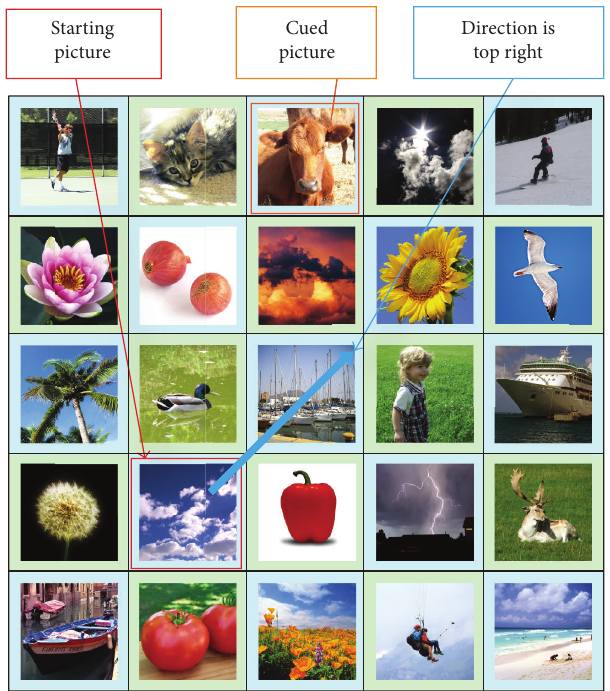
Figure 5: An example in determining